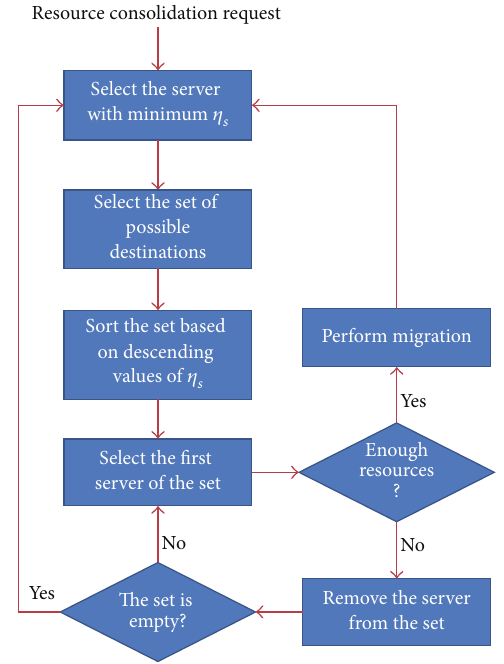
Figure 4: Flow chart of the SFC consolidation